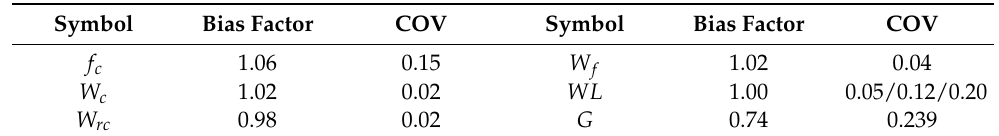
Table 2. Distribution characteristics.